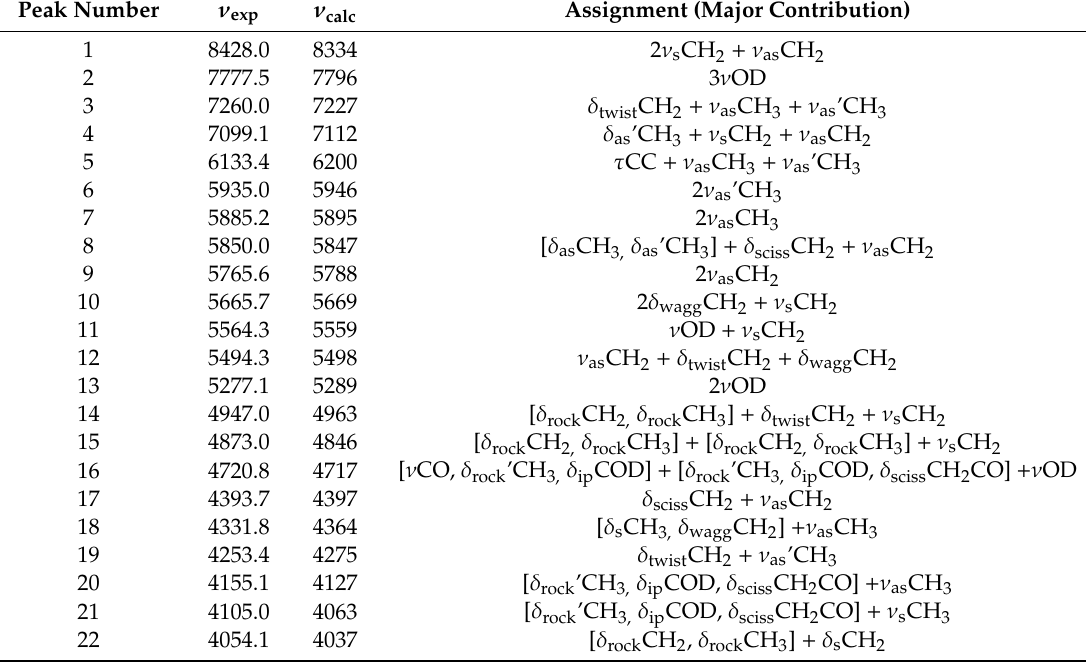
Table 3. Band assignments in NIR spectra of CH 3 CH 2 OD based on GVPT2 // B2PLYP-GD3BJ / def2-TZVP // CPCM calculations. Band numbering corresponds to that presented in Figure